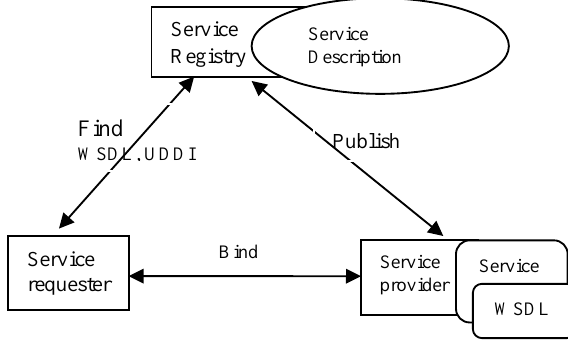
Figure 1 . Web Service Search